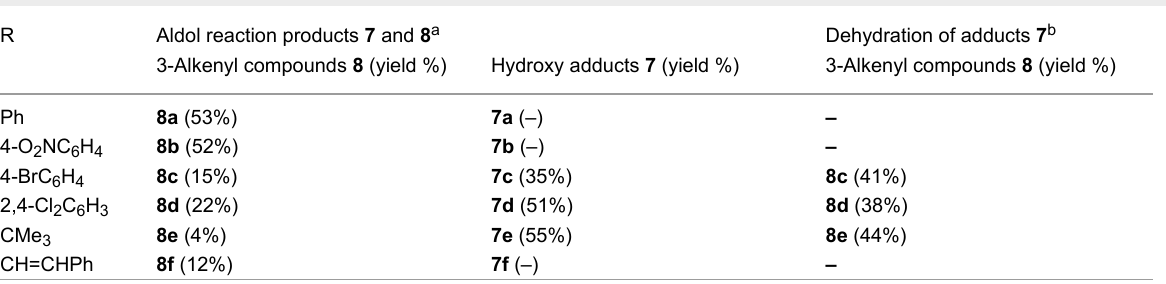
Table 1: Preparation of 3-alkenylisoxazolopyridones 8 , hydroxy adducts 7 , and dehydration of adducts 7 .